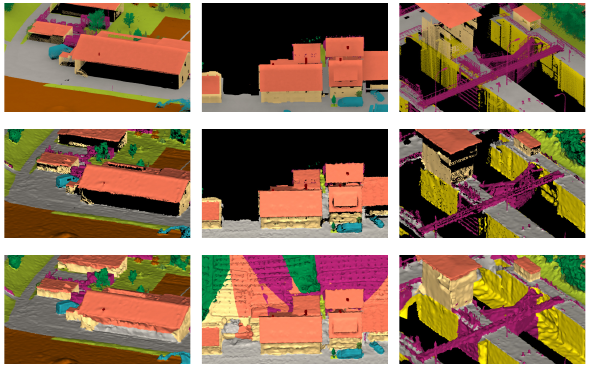
Figure 4. Effect of different propagation methods. The annotations of the manually labeled H3D PC ( top ) are propageted to the mesh by a) PCMA-steered transfer ( center ) or b) nearest neighbor interpolation ( bottom